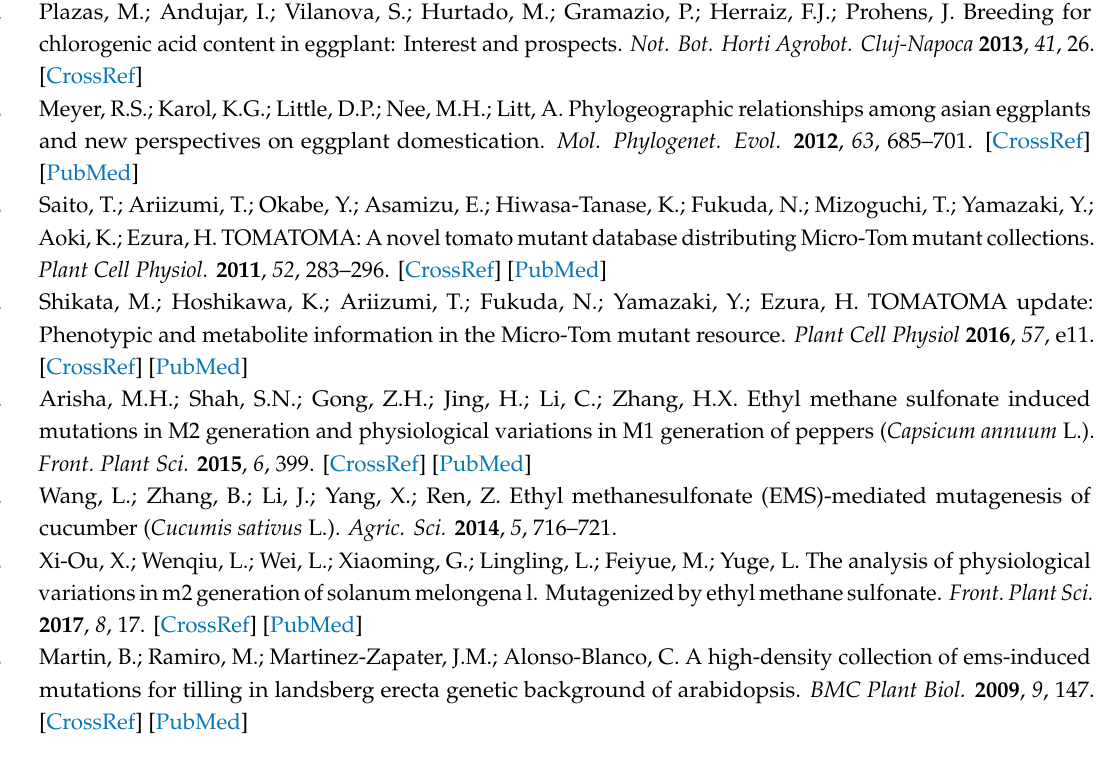
Supplementary Materials: The following are available online at http: // www.mdpi.com / 2073-4425 / 10 / 8 / 595 / s1, Table S1: The primers used for q-PCR.; Table S2: Pathway assignment based on high-impact mutation gene in the four EMS-induced mutants.; Table S3: The gene IDs involved in the anthocyanin synthesis. Figure S1: The nucleotide and protein sequence alignment of Sme2.5_06210.1_g00004.1 and Sme2.5_00228.1_g00013.1; Figure S2: The Sme2.5_06210.1_g00004.1 expression in four natural eggplant population. Author Contributions: X.X. designed the experiment and composed the manuscript. W.L. analyzed the gene expression and revised the manuscript. K.L. and X.F. analyzed the SNP and indels. H.J. and H.Z. investigated and analyzed the phenotypic